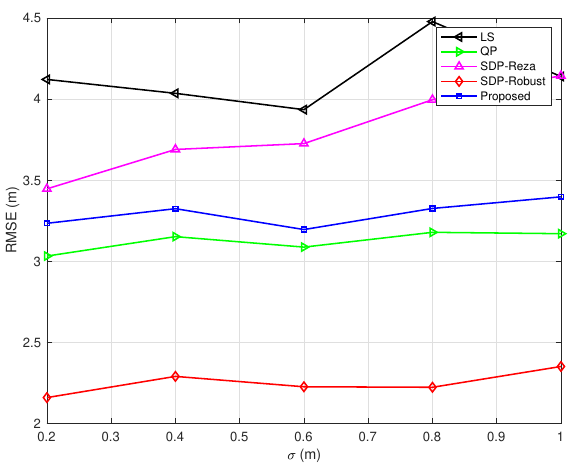
Figure 7. RMSEs vs. σ ( B max = 10 m and the number of NLOS links equals 8 )